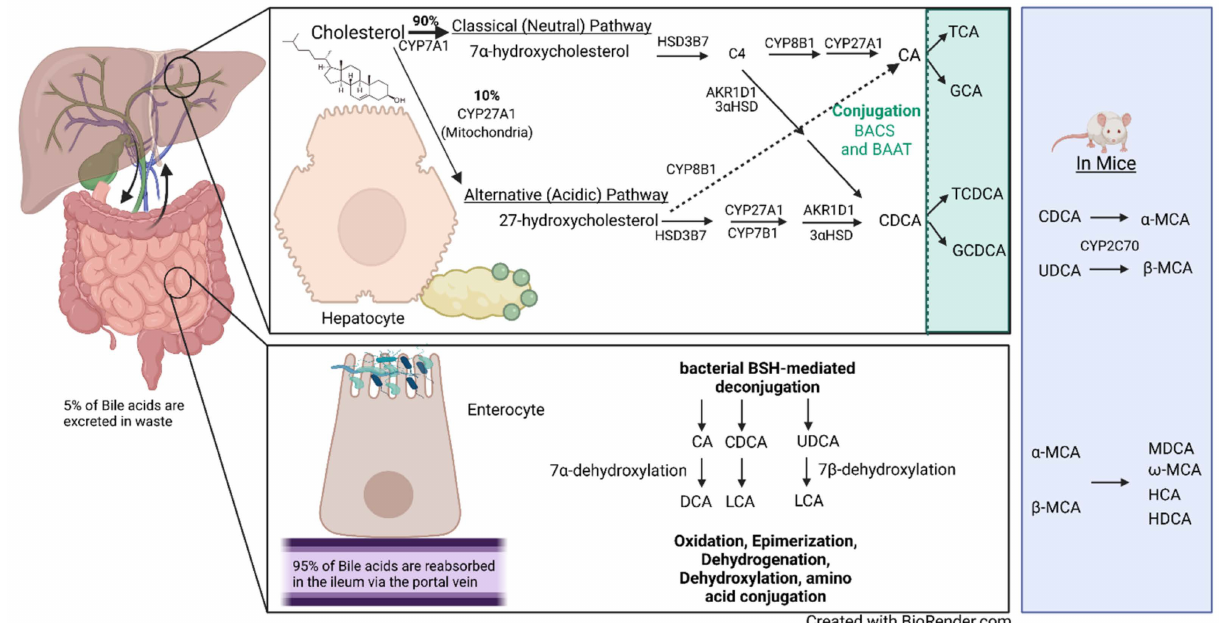
Figure 2. Bile acid metabolism and enterohepatic circulation. The human liver produces 0.5 g of bile per day via de novo synthesis. Only 5% of the secreted daily amount of bile acids is lost as waste each day. Bile acid synthesis can occur via the classical (neutral) pathway or the alternative (acidic) pathway. The classical pathway is regulated by cholesterol 7 α -hydroxylase (CYP7A1), the first enzyme and rate-limiting step in the pathway, which converts cholesterol to 7 α